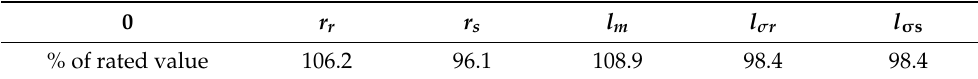
Table 1. Assumed inaccuracy of the IM parameters used in LO